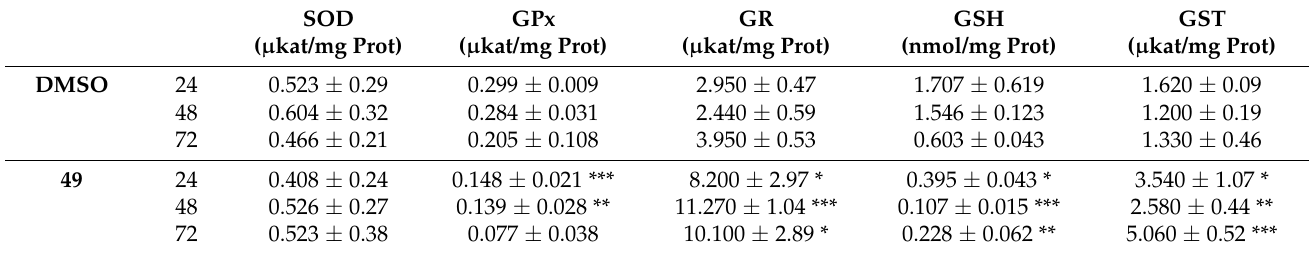
Table 2. Effect of compound 49 on glutathione (GSH), superoxide dismutase (SOD), glutathione peroxidase (GPx), glutathione reductase (GR) and glutathione-S-transferase (GST).